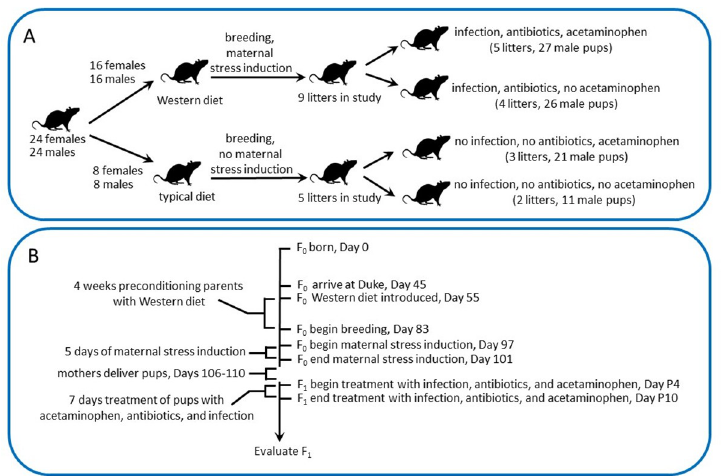
Fig 1. Experimental (A) design and (B) timeline. Rats were divided into four groups as described in the Methods. Two groups of animals received “oxidative stress induction” by preconditioning parents with a Western diet, maternal stress induction, and ampicillin treatment and mock infection with killed lactobacilli of male pups. Ampicillin and killed lactobacilli were administered together (mixed prior to injection) twice per day, 10 hours apart, for 7 days as described in the Methods. The other two groups received a normal laboratory rodent diet, no maternal stress induction, and injections with sterile saline as a control for injections with antibiotics and killed lactobacilli. Animals receiving oxidative stress induction were divided into two groups, with and without exposure to acetaminophen. Similarly, animals receiving no oxidative stress induction were divided into two groups, with and with exposure to acetaminophen. Acetaminophen was administered every five hours for seven days as described in the Methods. All animals receiving no acetaminophen received injections with sterile saline as a